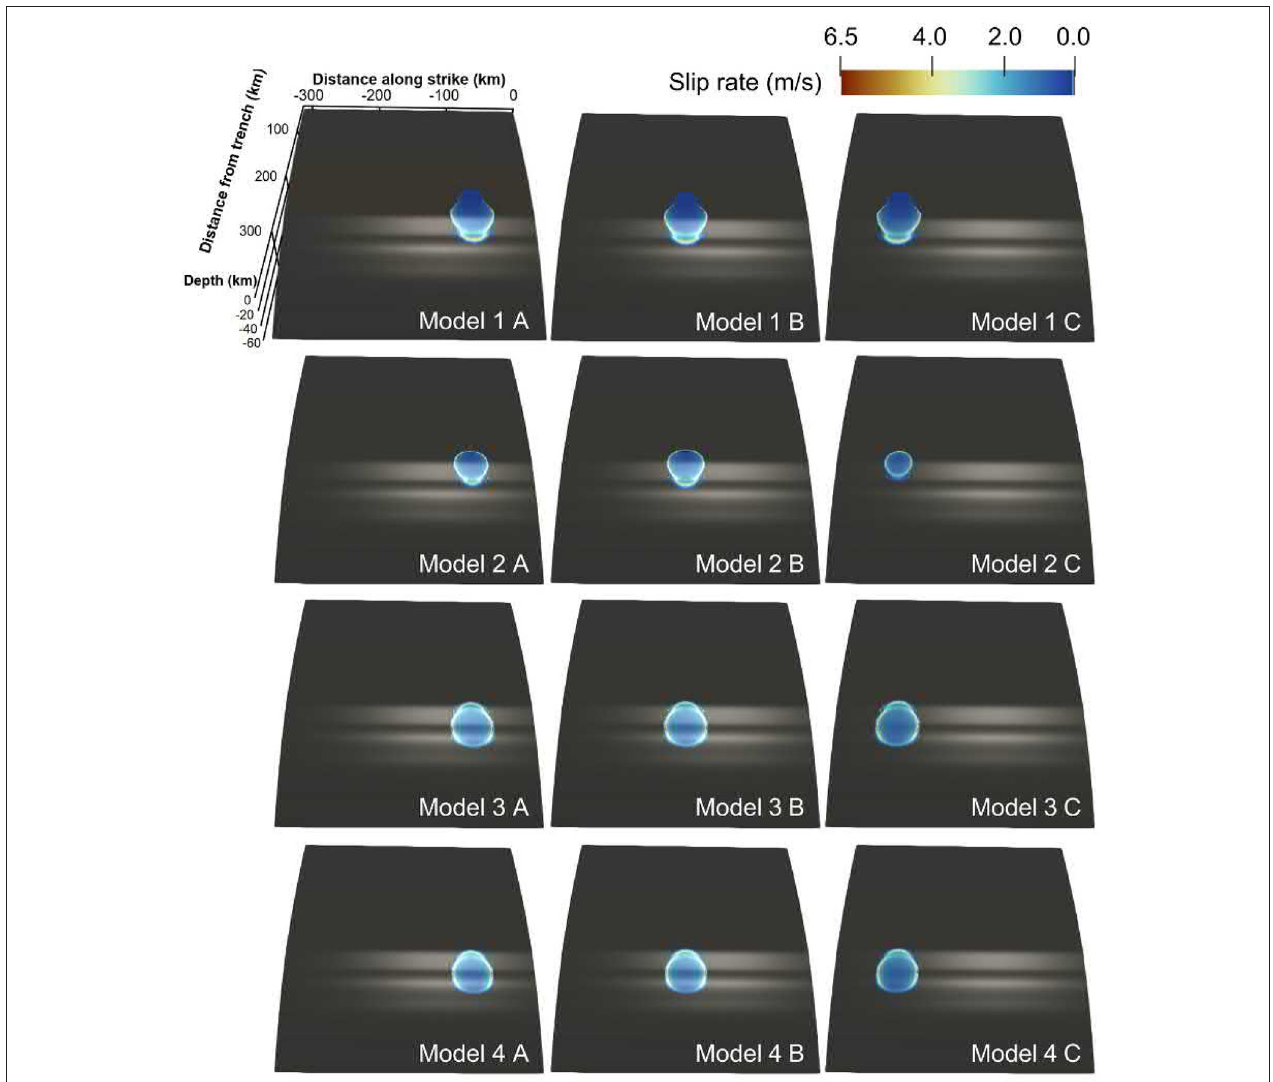
FIGURE 4 | Slip rate at the timestep t = 12 s (model 1), t = 16 s (model 2), t = 10 s (model 3), and t = 14 s (model 4), capturing down-dip and up-dip propagating supershear rupture being triggered by one of the two topographic highs in the fault geometry depending on hypocentral depth. The white reflections highlight the uneven geometry of the fault. The hypocentral locations vary with depth (25, 30, 40, and 45 km) and laterally on the fault (y = − 78.25 km, y = − 156.5 km, y = − 234.75 km). For model 1 and 2 supershear rupture evolves in downdip direction, whereas for model 3 and 4 in updip